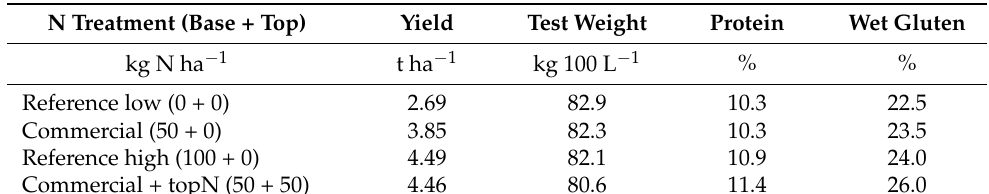
Table 4. N management: Grain yield and grain-quality parameters as affected by N treatment, in Beit Guvrin, field #109, 2020 season.